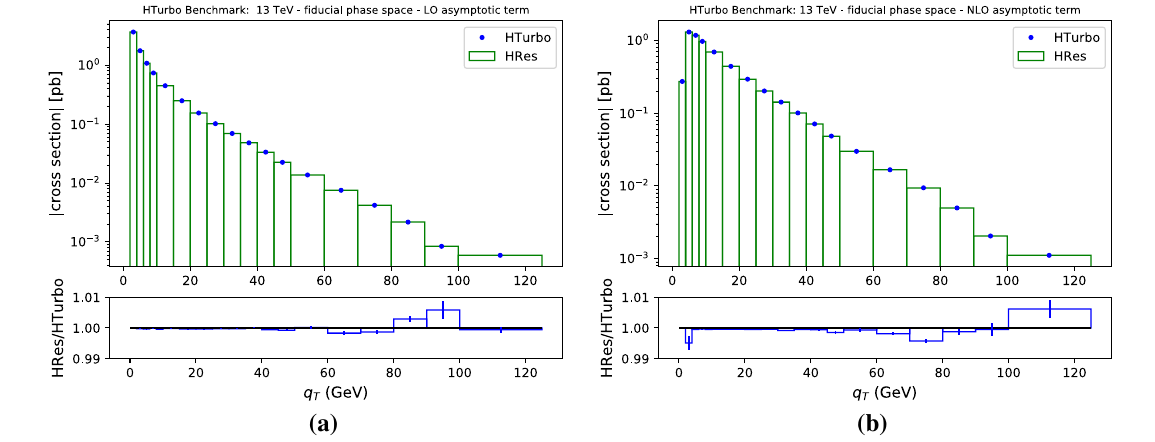
Fig. 5 Comparison of fiducial differential cross sections computed the transverse momentum distribution at LO ( a ) and NLO ( b ) accuracy. √ s = 13 TeV. The fiducial phase space with HRes and HTurbo at The top panels show absolute cross sections, and the bottom panels is defined in the text. Absolute value of the asymptotic component of show ratios of HTurbo to HRes results